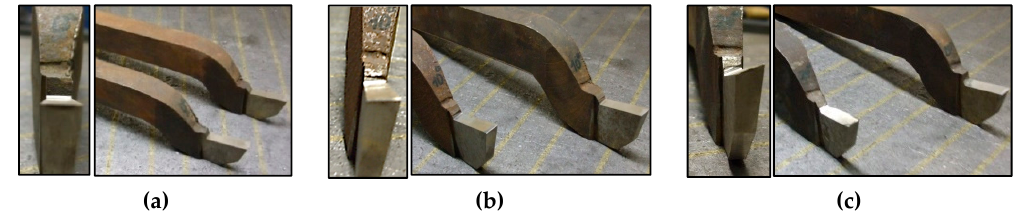
Figure 3. Planing necking tools, ( a ) λ s = 0°; ( b ) λ s = 10°; ( c ) λ s = 20°.